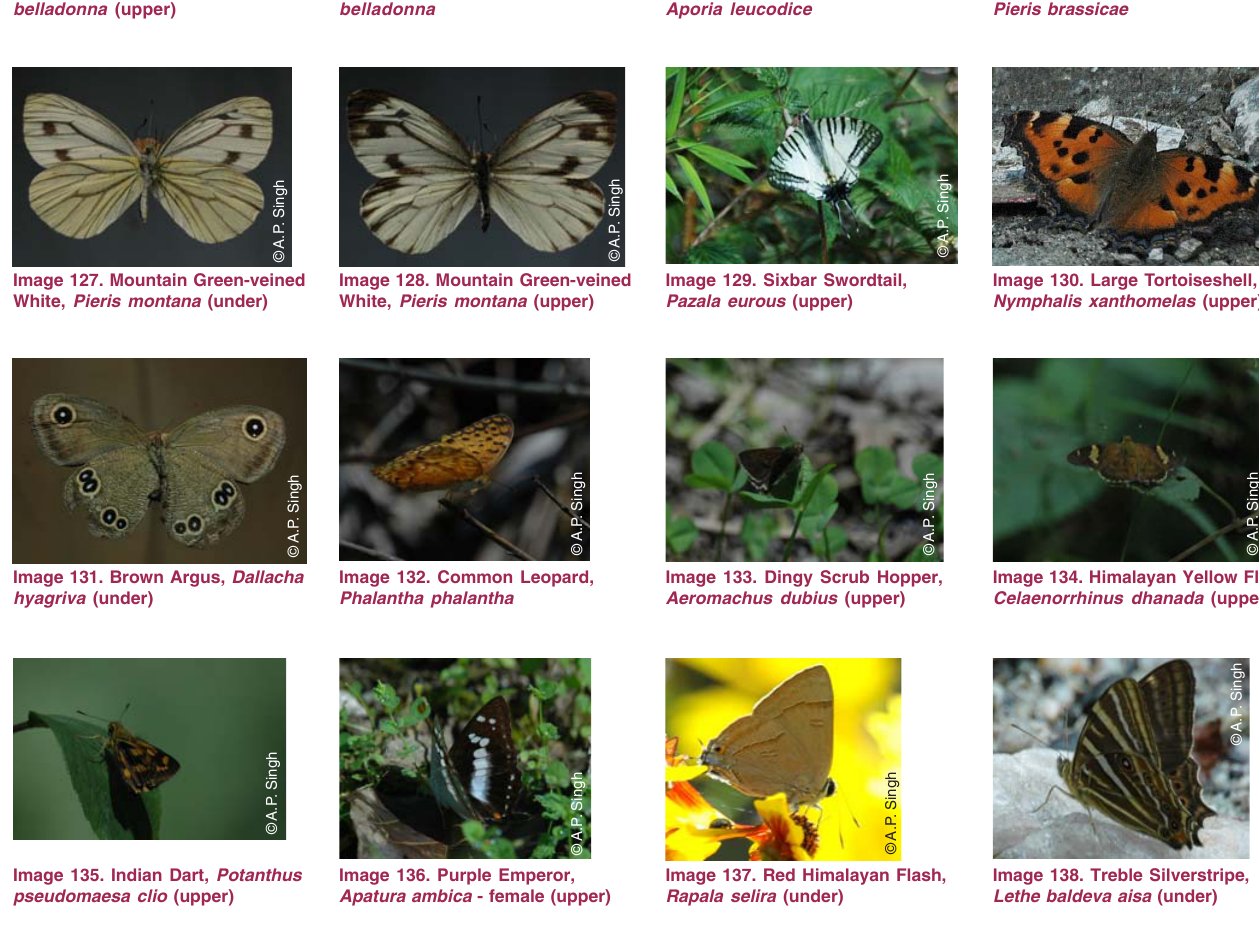
Image 136. Purple Emperor, Apatura ambica - female (upper)